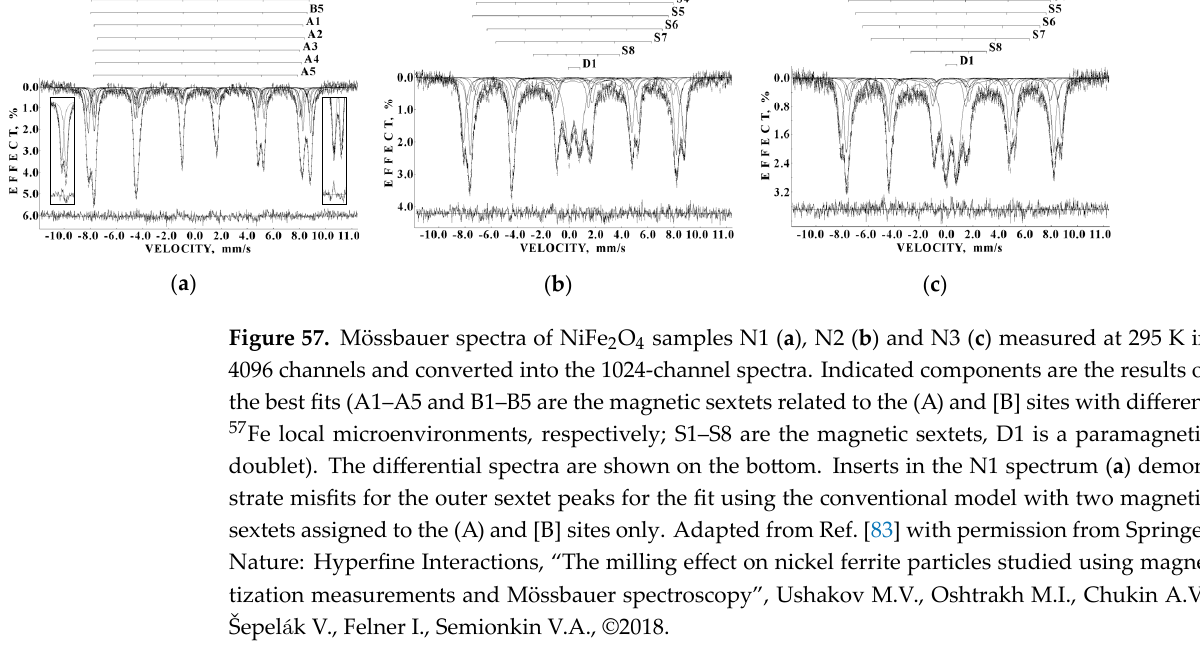
spectra were fitted using eight magnetic sextets and one quadrupole doublet.